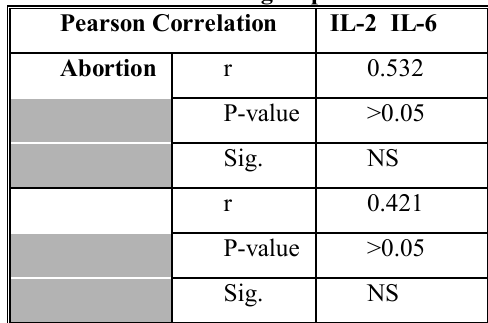
Table (3): Pearson correlation